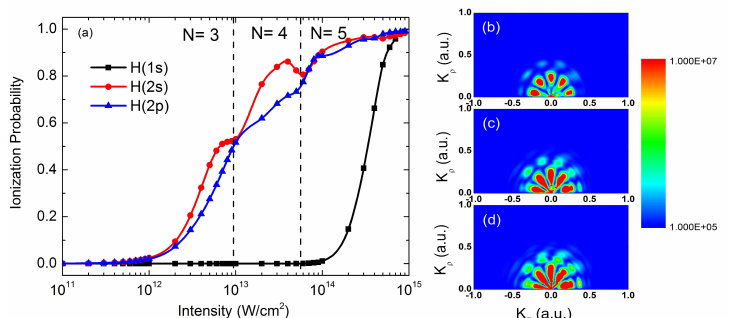
Figure 1. (Color online) ( a ) Ionization probability values of the K (1 s ) shell and L [(2 s ,2 p )] shell electrons of atomic hydrogen exposed to a laser pulse with width of 20 fs as a function of the peak intensity for 800 nm wavelength, solved by TDSE. Two-dimensional (2D) momentum distributions of 2 s initial electron under the three peak intensities 0.5 ( b ), 0.8 ( c ) and 1.0 × 10 13 W/cm 2 ( d ), which are around the channel-closing thresholds between N = 3 and N = 4. The channel-closing intensity for absorption of N photons is indicated in ( a